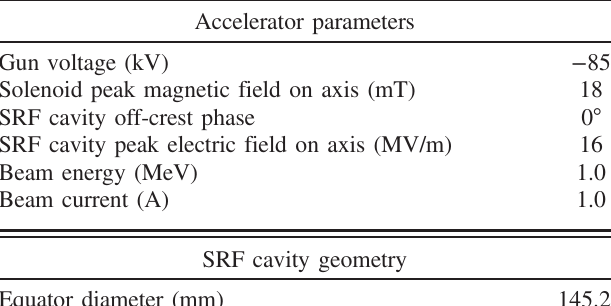
TABLE I. Main design parameters for the 915 MHz, high- power cw electron linac and the SRF